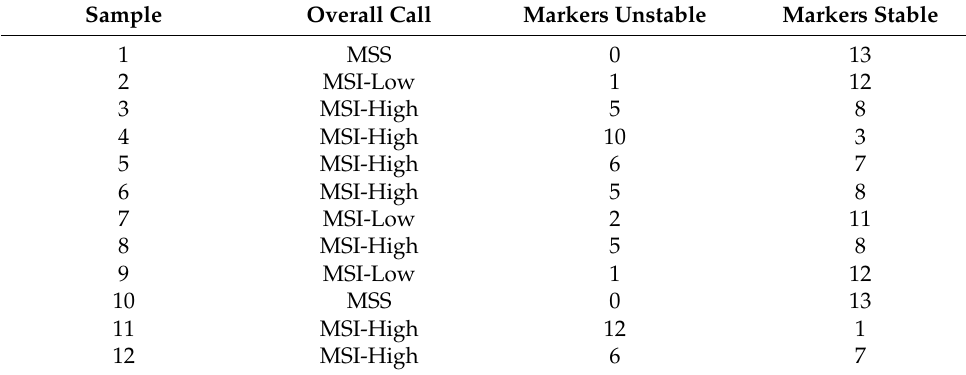
Table 4. Overview of the MSI